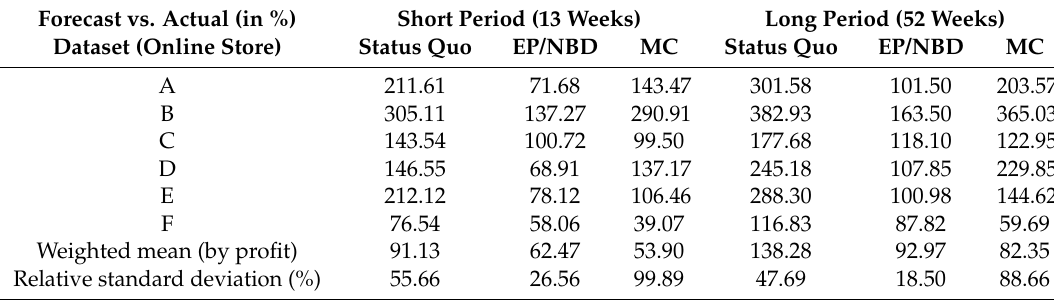
Table 3. Results for Forecast vs Actual (in %).